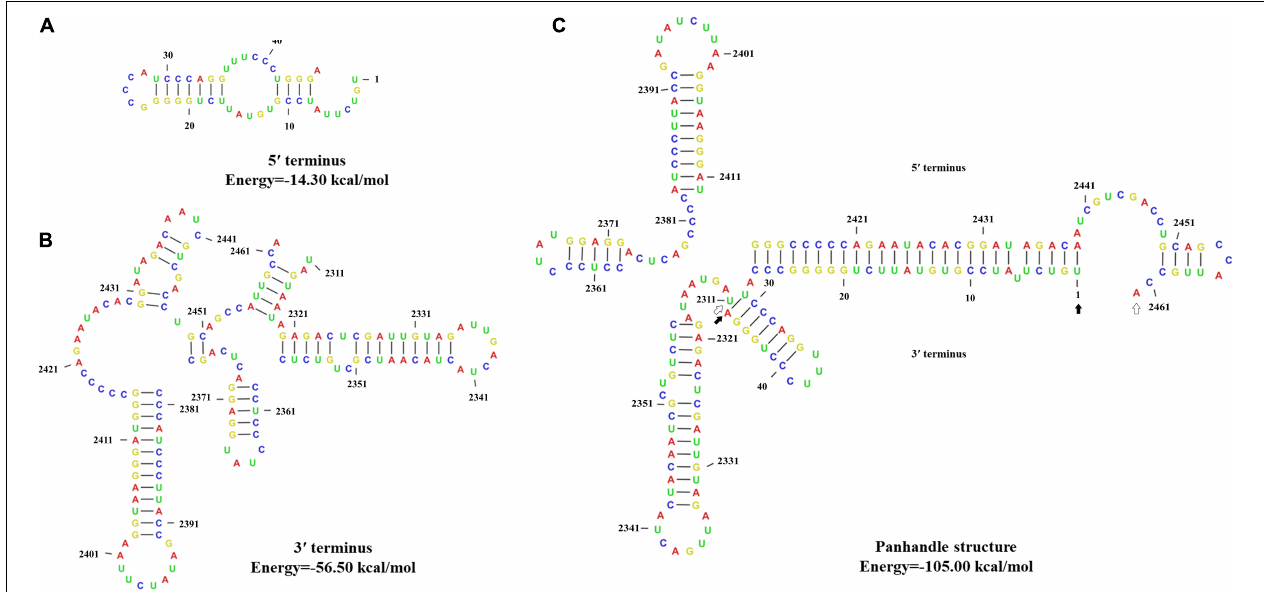
FIGURE 4 | Predicted secondary structures of the terminal sequences of MtMV1. (A,B) Stem-loop structures folded for the 5 (cid:48) - and 3 (cid:48) -UTR sequences of the genomic positive-strand, respectively. (C) Panhandle structure formed by the reverse complementary regions of the 5 (cid:48) - and 3 (cid:48) -UTRs ends of the MtMV1 genome. The CLC workbench software was used to predict the secondary structures of the terminal sequences and to calculate the free energy. The solid and open arrows indicate the 5 (cid:48) - and 3 (cid:48) -terminal sequences, respectively, in their initial and ending positions.